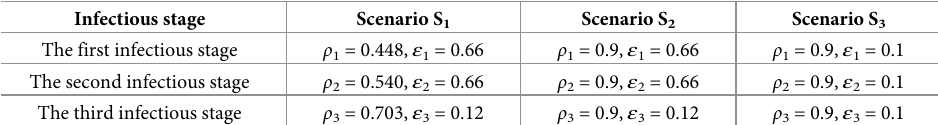
Table 5. Predicting